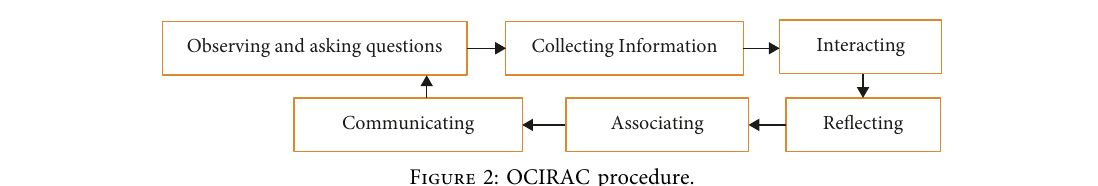
Figure 1: AI friends apps.